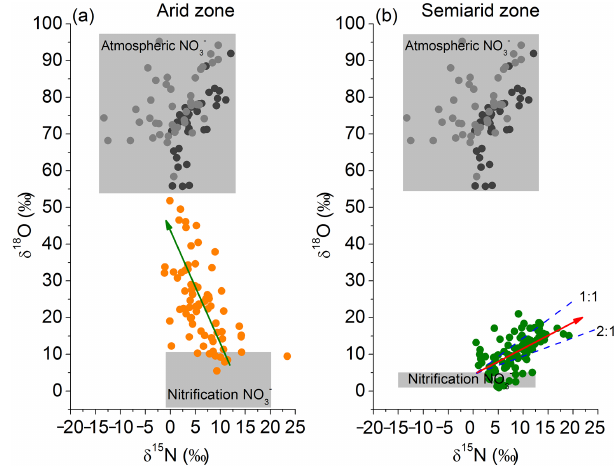
Figure 5. Relationship between δ 18 O and δ 15 N of soil NO − . The 3 range of δ 18 O and δ 15 N from atmospheric NO − was based on the 3 limited isotope measurement of precipitation. Black points repre- sent precipitation NO − collected from an urban site in Beijing in 3 the year 2012, with data derived from Tu et al. (2016). Grey points represent precipitation NO − collected from Qingyuan forest CERN 3 (Chinese Ecosystem Research Network, CERN) in northern China in the year 2014 (Huang and Fang, unpublished data). The ranges of δ 15 N and δ 18 O produced by nitrified NO − are positioned by using 3 the δ 15 N of soil NH + in this study (Fig. 2e) and the estimated δ 18 O 4 from soil nitrification based on the 1 : 2 ratio of soil O 2 and H 2 O (see Text),